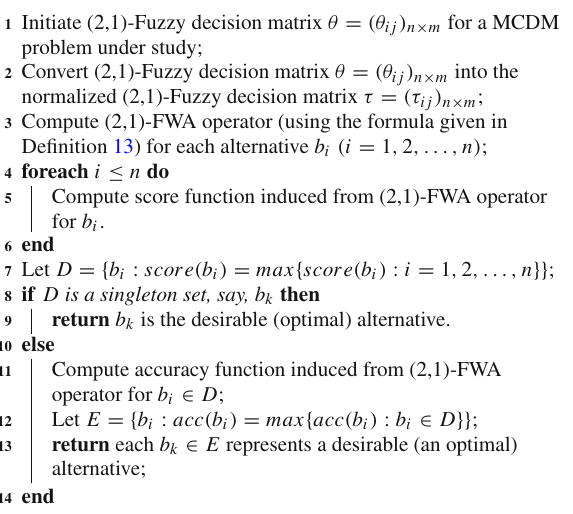
Algorithm 1: The algorithm of selection the